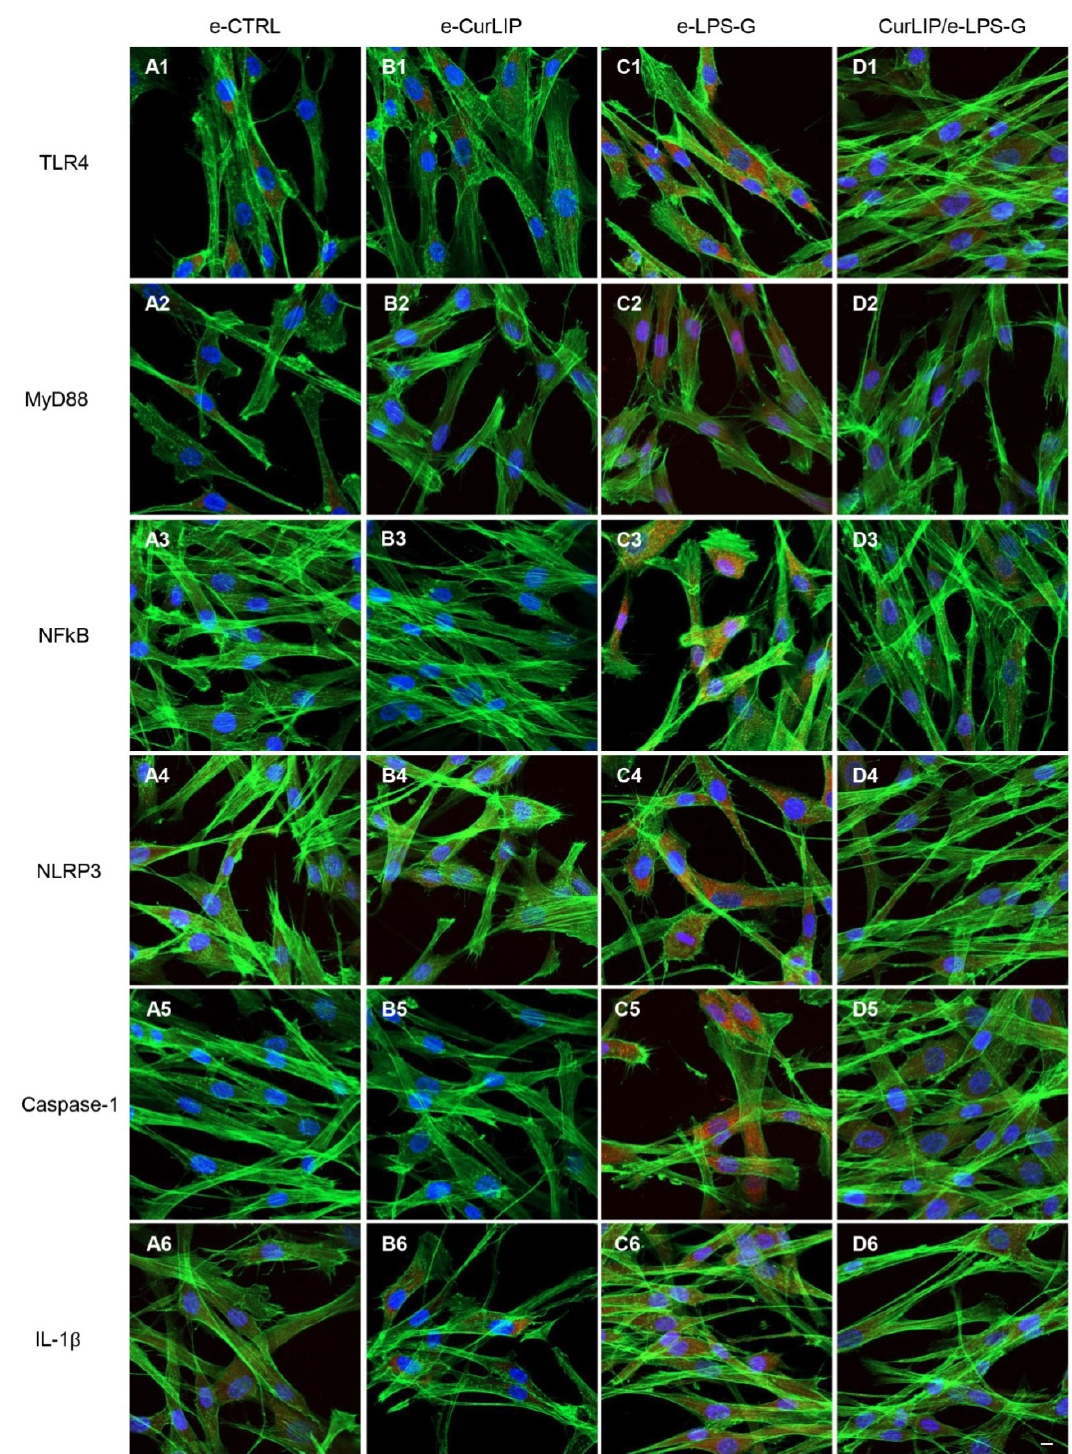
Figure 4. TLR4/MyD88/NFkB/NLRP3/Caspase-1/IL-1 β protein expression in e-hPDLSCs. The localization of TLR4/MyD88/NFkB/NLRP3/Caspase-1/IL-1 β was determined by immunofluorescence in all considered sample groups. Positive cells showed the protein expression in red, the cytoskeleton actin was marked in green and cell nuclei were stained with TOPRO in blue. (A1-D1) TLR4 expression in e-CTRL, e-CurLIP, e-LPS-G, CuRLIP/e-LPS-G. (A2-D2) MyD88 expression in e-CTRL, e-CurLIP, e-LPS-G, CuRLIP/e-LPS-G. (A3-D3) NFkB expression in e-CTRL, e-CurLIP, e-LPS-G, CuRLIP/e-LPS-G. (A4-D4) NLRP3 expression in e-CTRL, e-CurLIP, e-LPS-G, CuRLIP/e-LPS-G. (A5-D5) Caspase-1 expression in e-CTRL, e-CurLIP, e-LPS-G, CuRLIP/e-LPS-G. (A6-D6) IL-1 β expression in e-CTRL, e-CurLIP, e-LPS-G, CuRLIP/e-LPS-G. Scale bar = 10 µm.